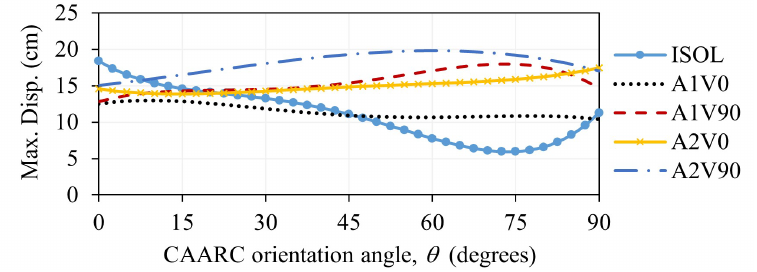
Figure 9. Maximum displacement at the top of the CAARC, x-direction.